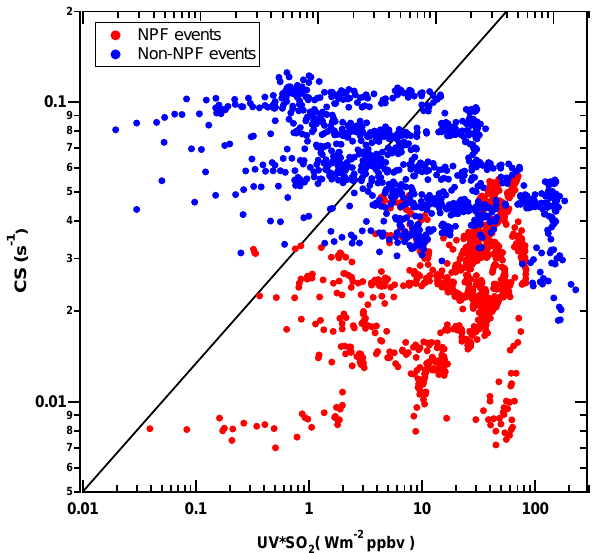
Fig. 5. Scatter plot of UV × SO 2 versus condensation sink during the NPF events (red dots) and non-NPF events (blue dots). Condensational sink ( y axis-left) is plotted against the product of ultraviolet light intensity and SO 2 concentration ( x axis). Four-minute averaged values are plotted from the event start time to the event end time on NPF event days. On non-NPF event days, a time range from 0800 to 1600LT is applied.